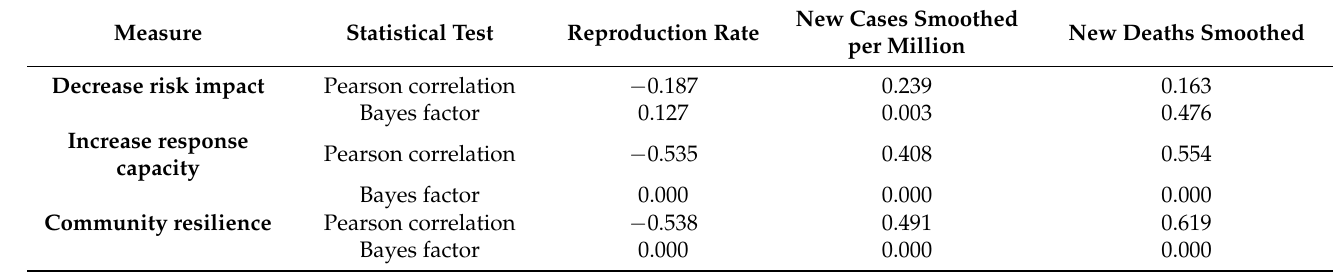
Table 2. Statistical analysis of data series regarding non-pharmacological measures to combat the pandemic by the Pearson correlation and Bayesian